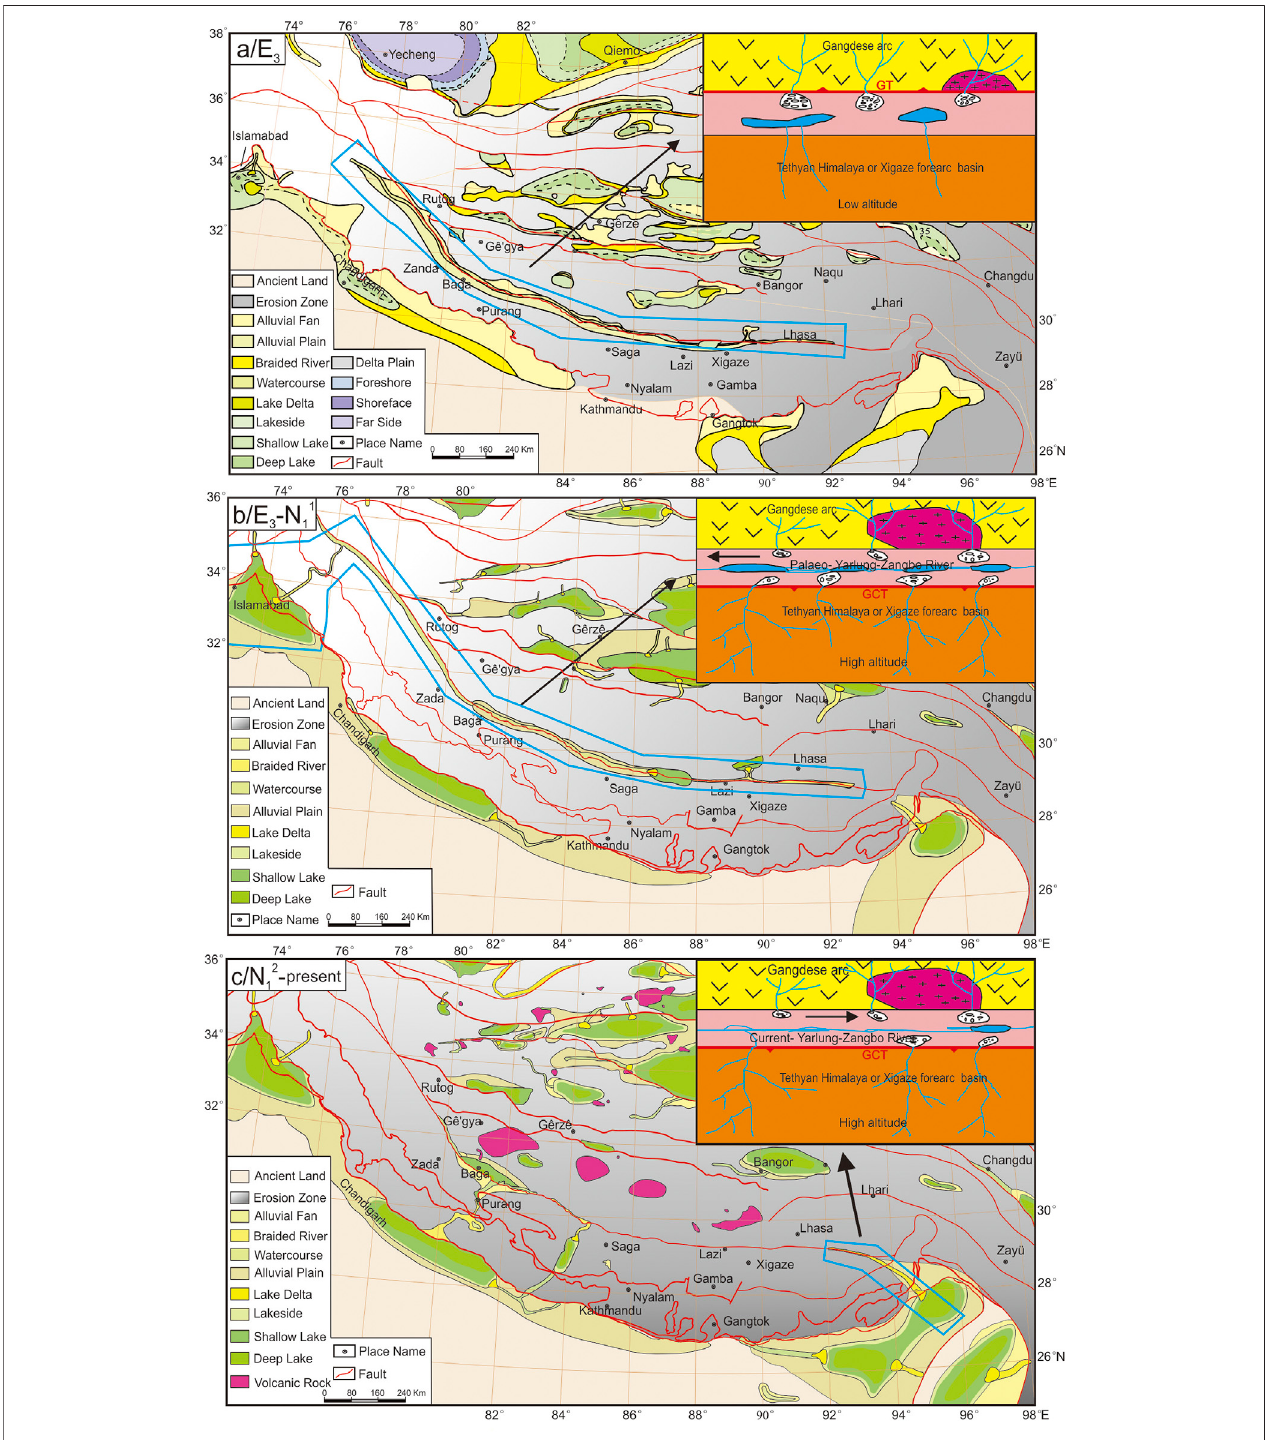
FIGURE 10 | Sketch map of evolution of palaeo-Yarlung-Zangbo River (A,B) and current Yarlung-Zangbo River (C) . (Modi fi ed after Zhang et al., 2013b)